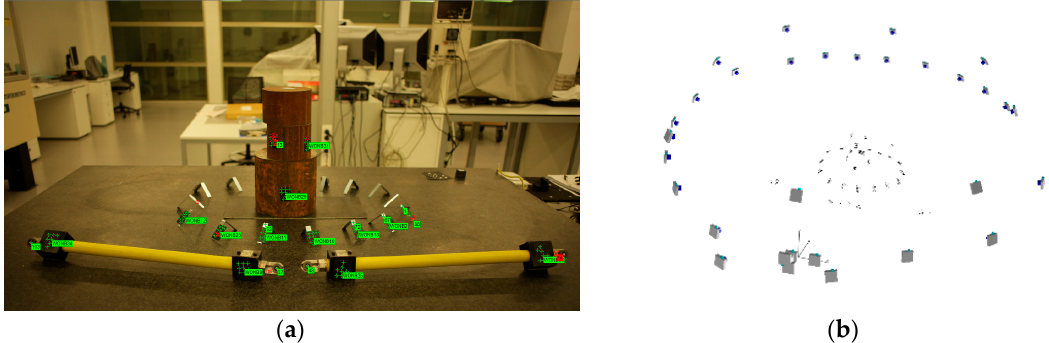
Figure 8. Automated orientation in lab: ( a ) coded target image identification (in green); and ( b ) sparse triangulation of coded targets and camera network